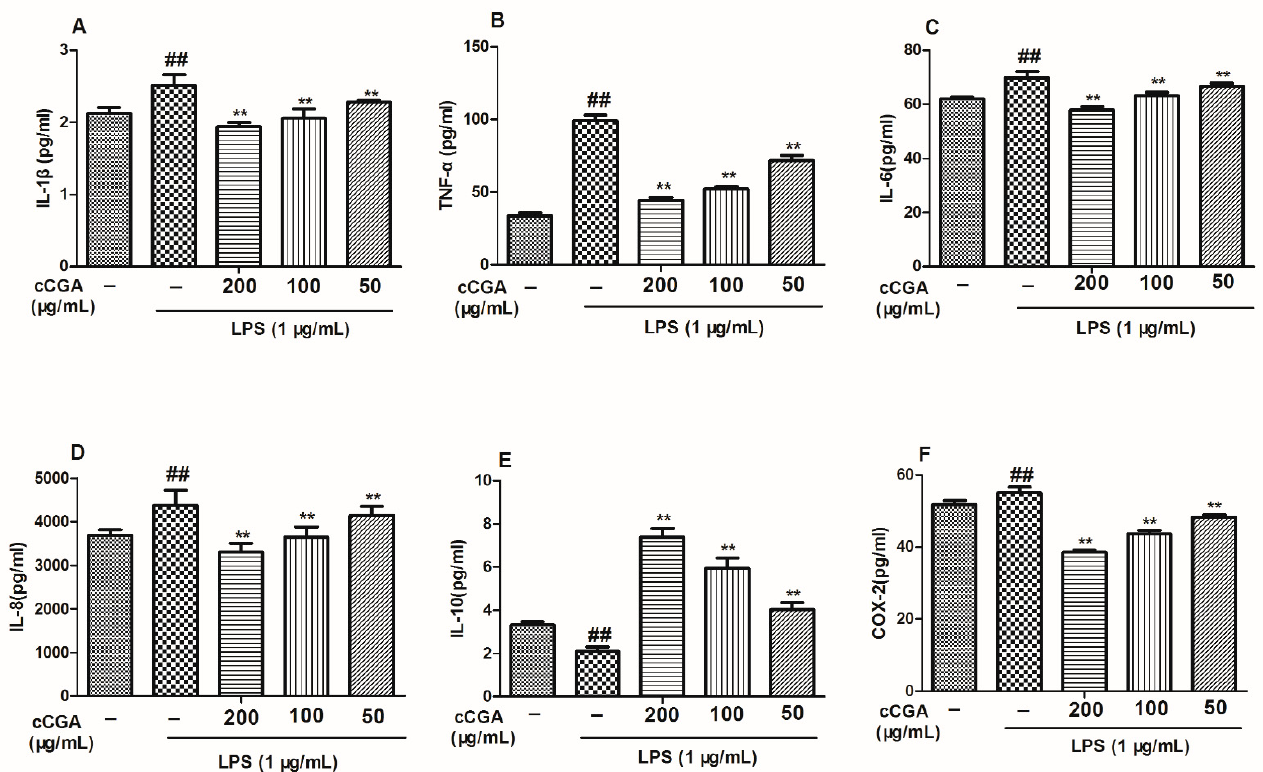
Figure 8. Effects of CCGA from A. adenophora on protein levels of inflammatory-related cytokines and COX-2 in LPS-induced RAW264.7 cells. ( A – E ) Protein levels of inflammatory-related cytokines. ( F ) Protein expression of COX-2. Notes: ## p < 0.01 vs. blank control group, ** p < 0.01 vs. LPS, n = 9 (mean ± standard deviation).